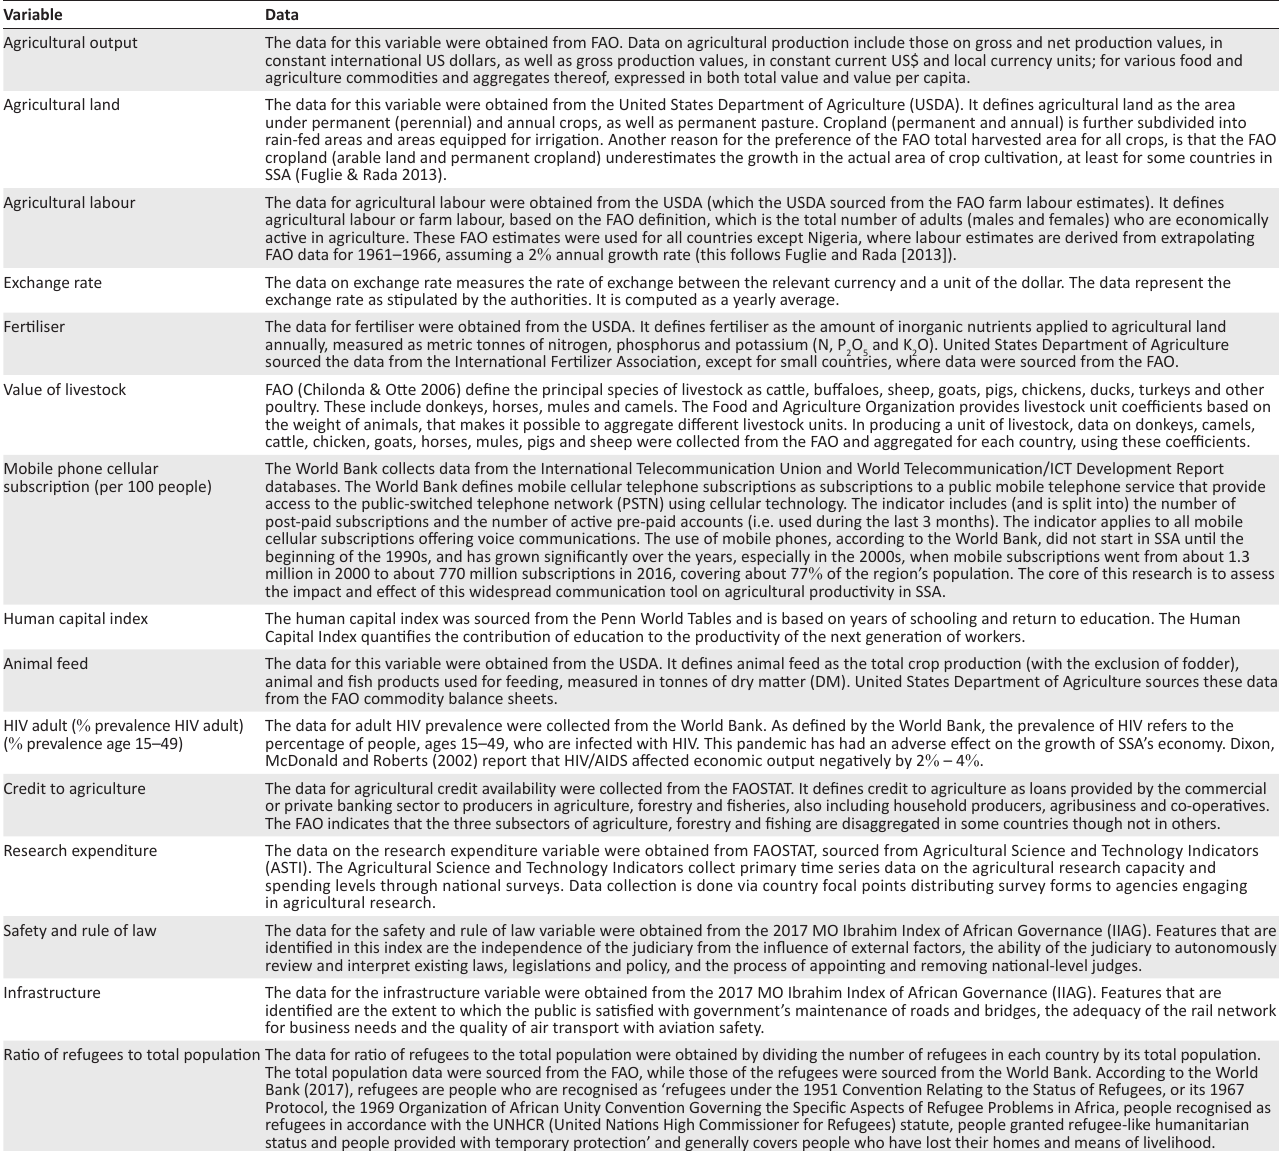
TABLE 2: Production and productivity